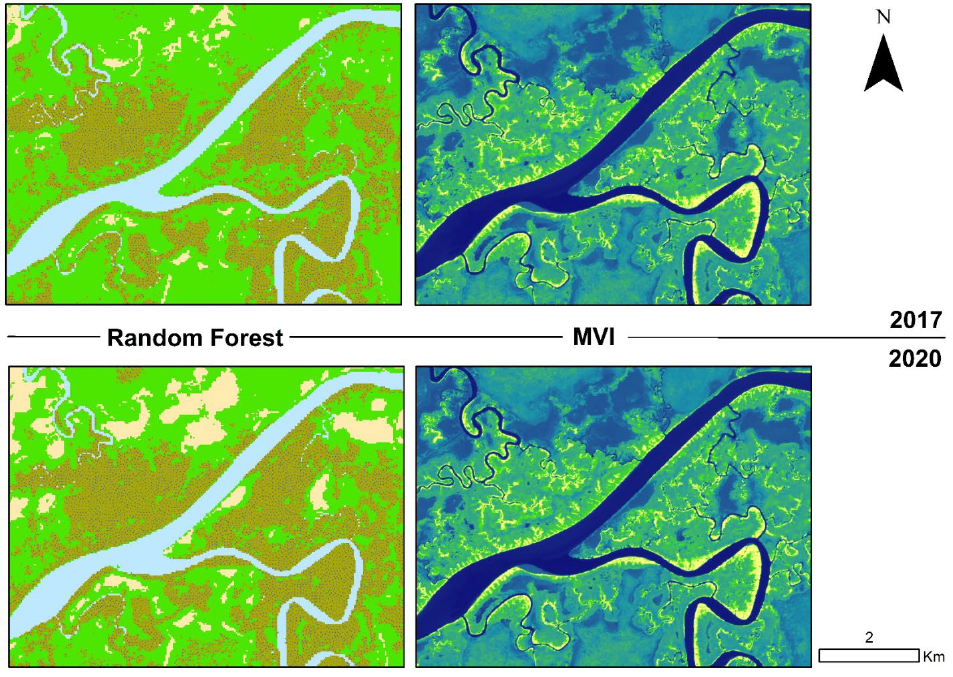
Figure 5 . Comparison of RF (left) and MVI